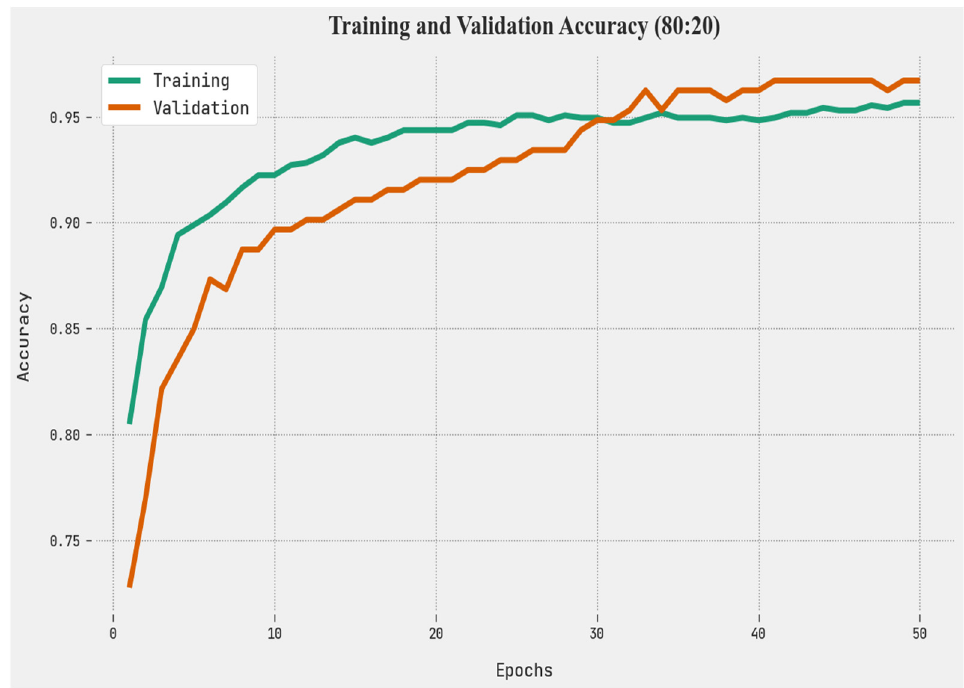
Figure 6. TACC and VACC analysis of TSADL-LULCCD method on 80:20 of TR/TS databases.